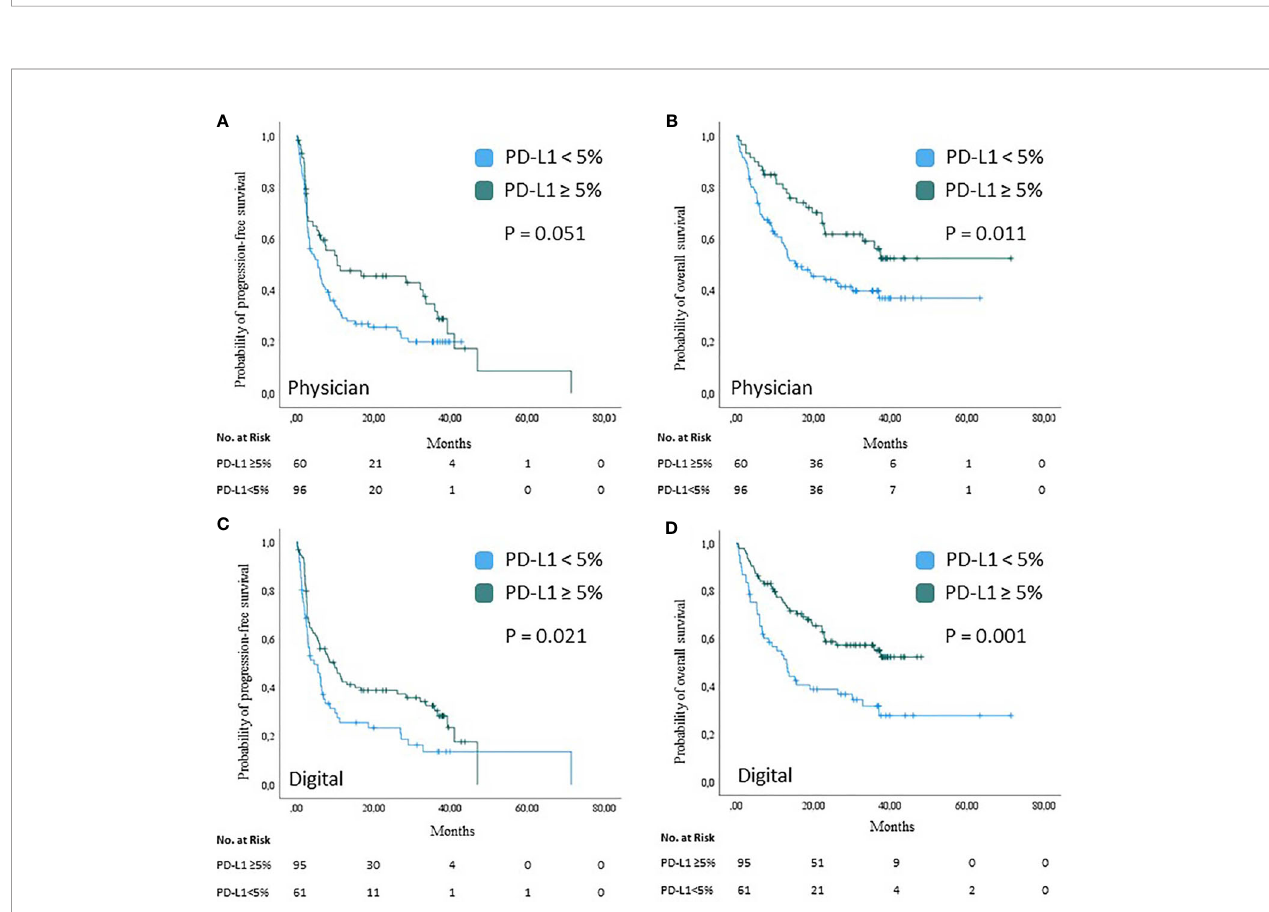
FIGURE 4 | Survival analysis based on PD-L1 expression analysis by physician or digital algorithm. Kaplan-Meier curves showing the probability of progression-free (A, C) and overall (B, D) survival of n=156 melanoma patients upon treatment with PD-1-based immune checkpoint blockade by tumor PD-L1 expression. Tumor PD-L1 expression was assessed by physician ’ s quanti fi cation (A, B) and digital quanti fi cation (C, D) , respectively. Censored observations are indicated by vertical bars; P values were calculated using the log-rank